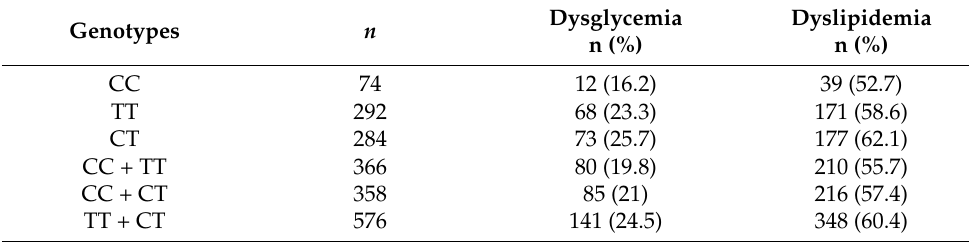
Table 2. Distribution of dysglycemia and dyslipidemia in people with different ABCA1 C69T genotypes.